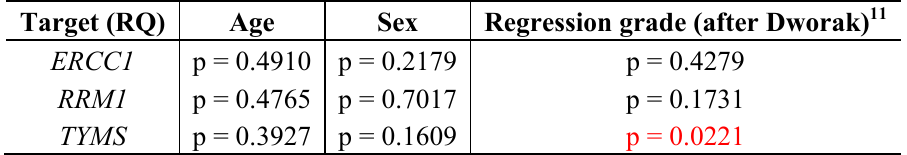
Table 7. Correlation between the relative quantification (2 - ∆∆ CT ) of each gene target ( ERCC1 , RRM1 and TYMS ), the age, sex and regression grade status of all samples statistically evaluated by the application of the Chi 2 -test. A statistically significant correlation between TYMS and the regression grade was